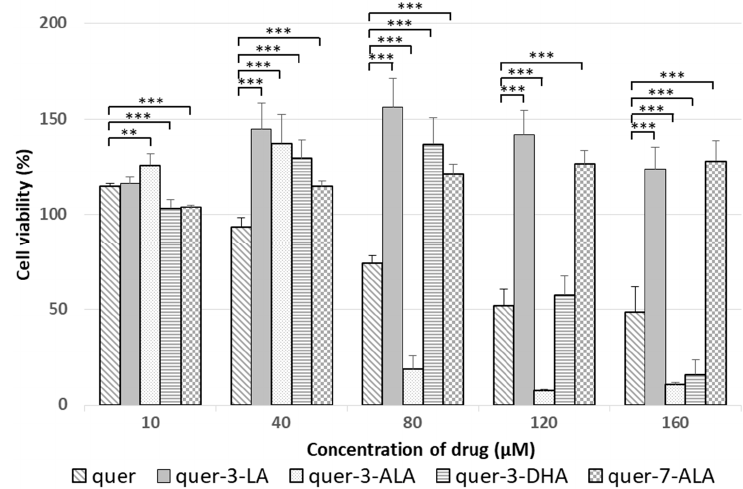
Figure 8. Cytotoxicity assay: representation of ARPE-19 cell viability in presence of PUFA quercetin derivatives; natural quercetin ( quer ), quer-3-LA ( 13 ), quer-3-ALA ( 14 ), quer-3-DHA ( 15 ) and quer-7-ALA ( 18 ) expressed as percentage of viability in function of drug concentration introduced on cells. Results are expressed in mean ± SD and are from at least n = 3 independent experiments. Results are normalized with 100% viability for non-treated control cells. Student’s t-test or Mann-Whitney’s test, * p < 0.05, ** p < 0.01, *** p < 0.001, versus natural quercetin ( quer ) at equivalent concentration. 4.3. Antioxidant Properties of Lipophenols: ROS Scavenging and Protection against Oxidized A2E For most of the series (phloroglucinol, resveratrol and quercetin), an important loss of ROS scavenging properties was observed when one lipid is associated to the phenolic backbone. For the phloroglucinol derivative, phloro-LA is nine times less potent than its natural homologue. Regarding the resveratrol series, this loss is even more important as only 40% of ROS is scavenged by resv-LA at 80 μ M (Figure S1). The same result was observed by Oh et al. [55] in non-cellular DPPH and ABTS assays, where substitution of hydroxyl group(s) appeared to negatively affect the antioxidant activity of the resveratrol derivatives. Natural quercetin displayed a high antioxidant activity with an IC 50 in the same range compared to phloroglucinol, resveratrol and (+)-catechin. When position 3 was substituted by one LA moiety (quer-3-LA), ROS scavenging properties were highly decreased but still more potent than its homologues phloro-LA and resv-LA. Mainini et al. [24] evaluated fatty acid- quercetin derivatives using either stearic, oleic, linoleic or linolenic acids to form penta-(3,5,7,3 ′ ,4 ′ ), tetra-(3,7,3 ′ ,4 ′ ) or tri-(7,3 ′ ,4 ′ ) esters and also demonstrated, in non-cellular assay, a systematic decrease of antioxidant properties of the lipophenol derivatives associated with the number of phenolic function esterified. This subsiding activity has been frequently observed in DPPH or ABTS non-cellular antioxidant assays performed on lipophilized polyphenols [24,56–58]. However, different conclusions have been described from experiments carried out in a bulk oil system, where, for example, resveratrol ester is able to outperform the antioxidant capacity of the original resveratrol [59]. By performing ROS inhibition assay in a cellular media, one could anticipate that the increase in cell penetration (due to increased lipophilicity) confers to the lipophilic derivatives a more potent effect than their native polyphenol. However, this was not observed. This decreased ROS scavenging potency could be explained by the loss of a phenol function due to introduction of the fatty acid but could not be the only explanation since lipophilized phlroridzin, rutin or isoquercitrin have shown reduced antioxidant capacity even when the lipid part was localized on the sugar hydroxyl, which does not participate in the ROS scavenging mechanism [57,58].